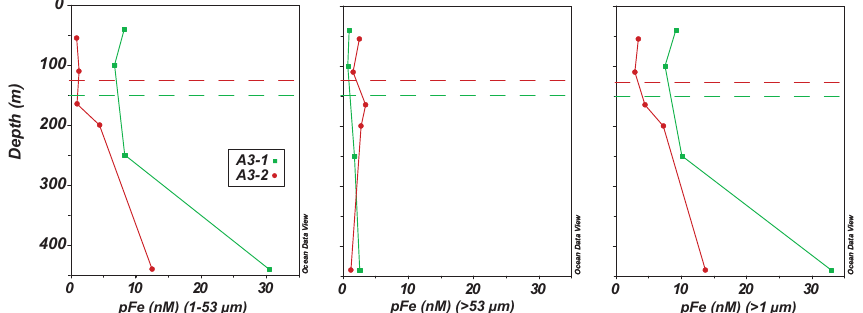
Figure 4. Particulate Fe at the plateau station (A3) by size class. The integrated full water column pFe (>1µm) reduced by 51% between A3-1 and A3-2 (9.1–4.5mMolm − 2 at A3-1 and A3-2 respectively). The integrated mixed layer pFe reduced by 70% between A3-1 and A3-2 (1.4–0.56mMolm − 2 at A3-1 and A3-2 respectively). The mixed layer shoaled between A3-1 and A3-2 as illustrated by the dashed horizontal line. The calculation of integrated mixed layer pFe used a constant mixed layer depth of 165m for both A3-1 and A3-2 to allow comparison between these